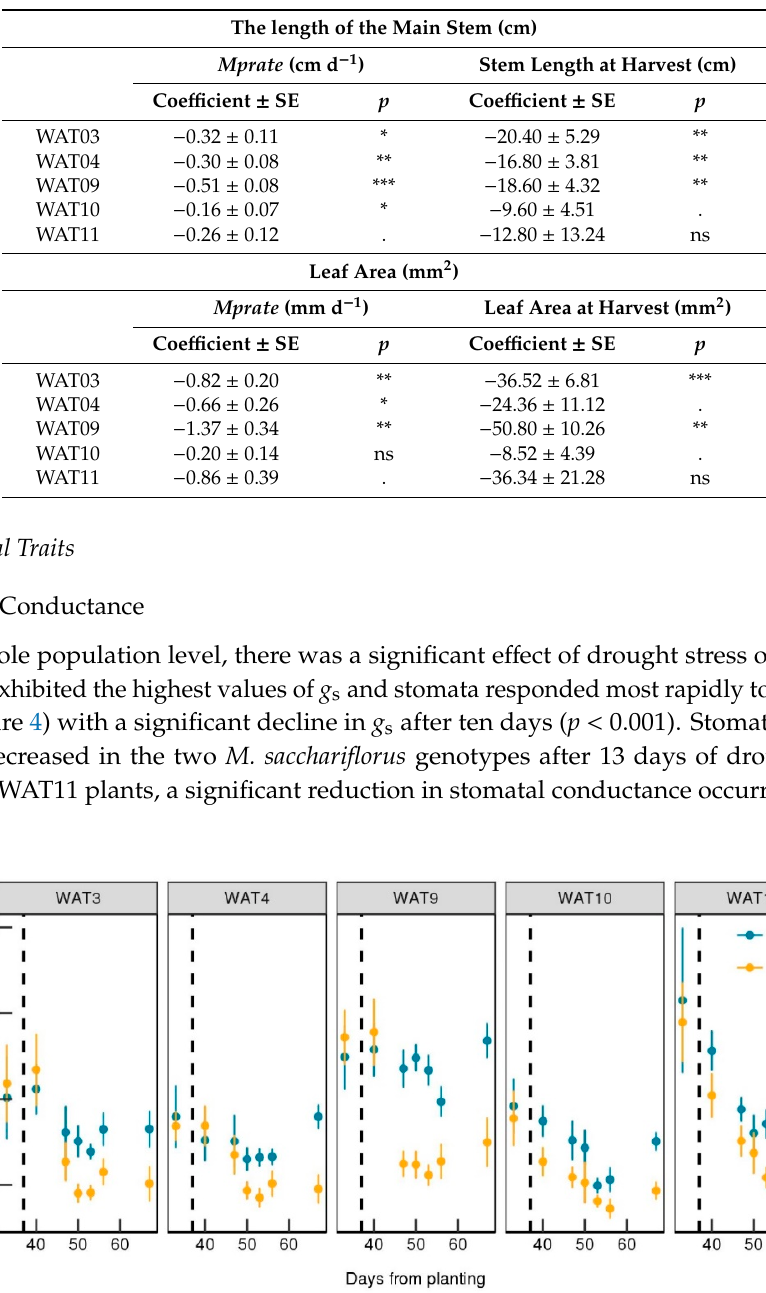
Figure 4. Stomatal conductance ( g s ). The change in stomatal conductance of 5 miscanthus genotypes growing for 75 days, drought stress was applied to half the plants at day 37 indicated by the vertical dashed line. Values represent means ± SEM ( n = 5); SEM—standard error of the mean.